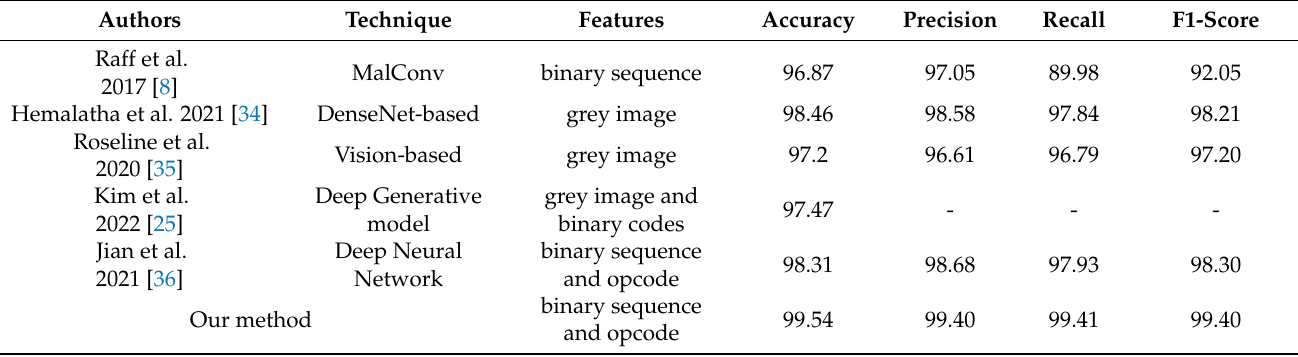
Table 6. Comparisons with the existing models on Dataset